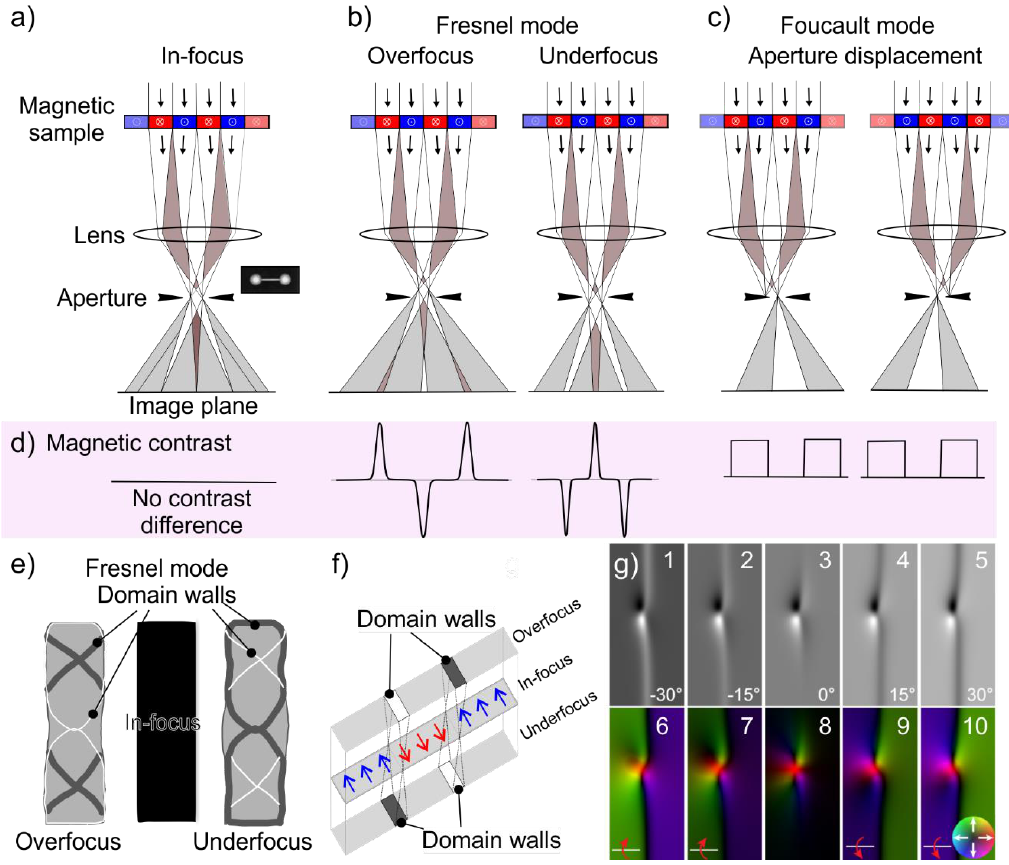
Figure 11. Lorentz microscope ( a ) in-focus; ( b ) overfocus and underfocus Fresnel mode TEM imaging; ( c ) Foucault mode; ( d ) the related magnetic contrast imaging; ( e ) domain wall contrast inversion in Fresnel mode; ( f ) scheme of the inverse bright/dark contrast corresponding at the positions of the magnetic domain walls in defocused Fresnel; and ( g ) bright-field Fresnel-mode L-TEM image sequence (1–5) of an isolated DW skyrmion collected with a different tilting angle and the corresponding in-plane magnetic induction maps (6–10) as obtained by TIE. Panel g reprinted with permission from [152], copyright by American Physical Society, 2019.